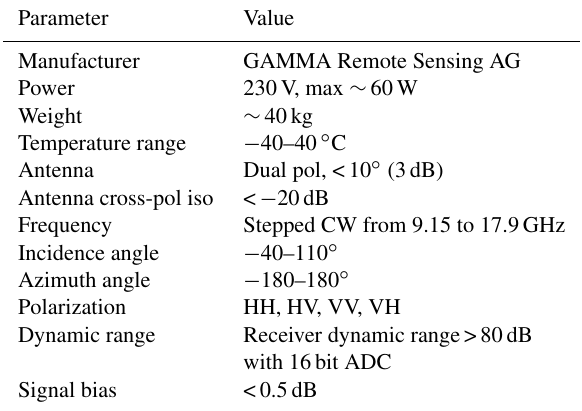
Table 1. SnowScat technical